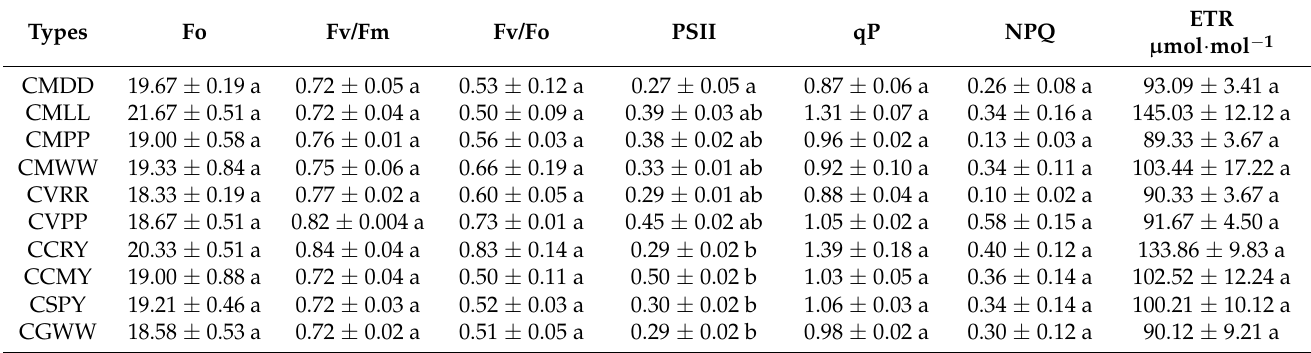
Table 3. Chlorophyll fluorescence parameters of 10 Cypripedium samples, including Fo, Fv/Fm, Fv/Fo, PSII, qP, NPQ, and